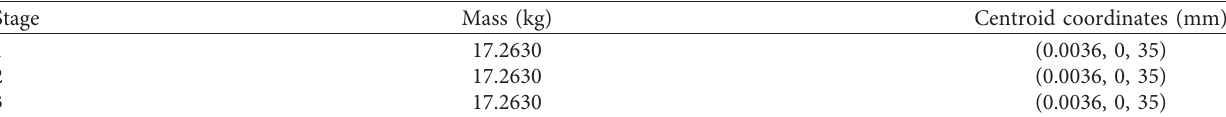
Table 2: The mass parameters of the 3-stage rotor are measured by